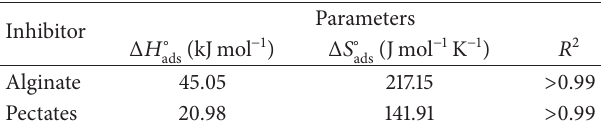
Table 5: Thermodynamic parameters of Δ𝐻 ∘ corrosionofAlinalkalinemediaintheabsenceandpresenceofALG and PEC inhibitors. [OH − ] = 4.0 and I = 4.0mol dm − 3